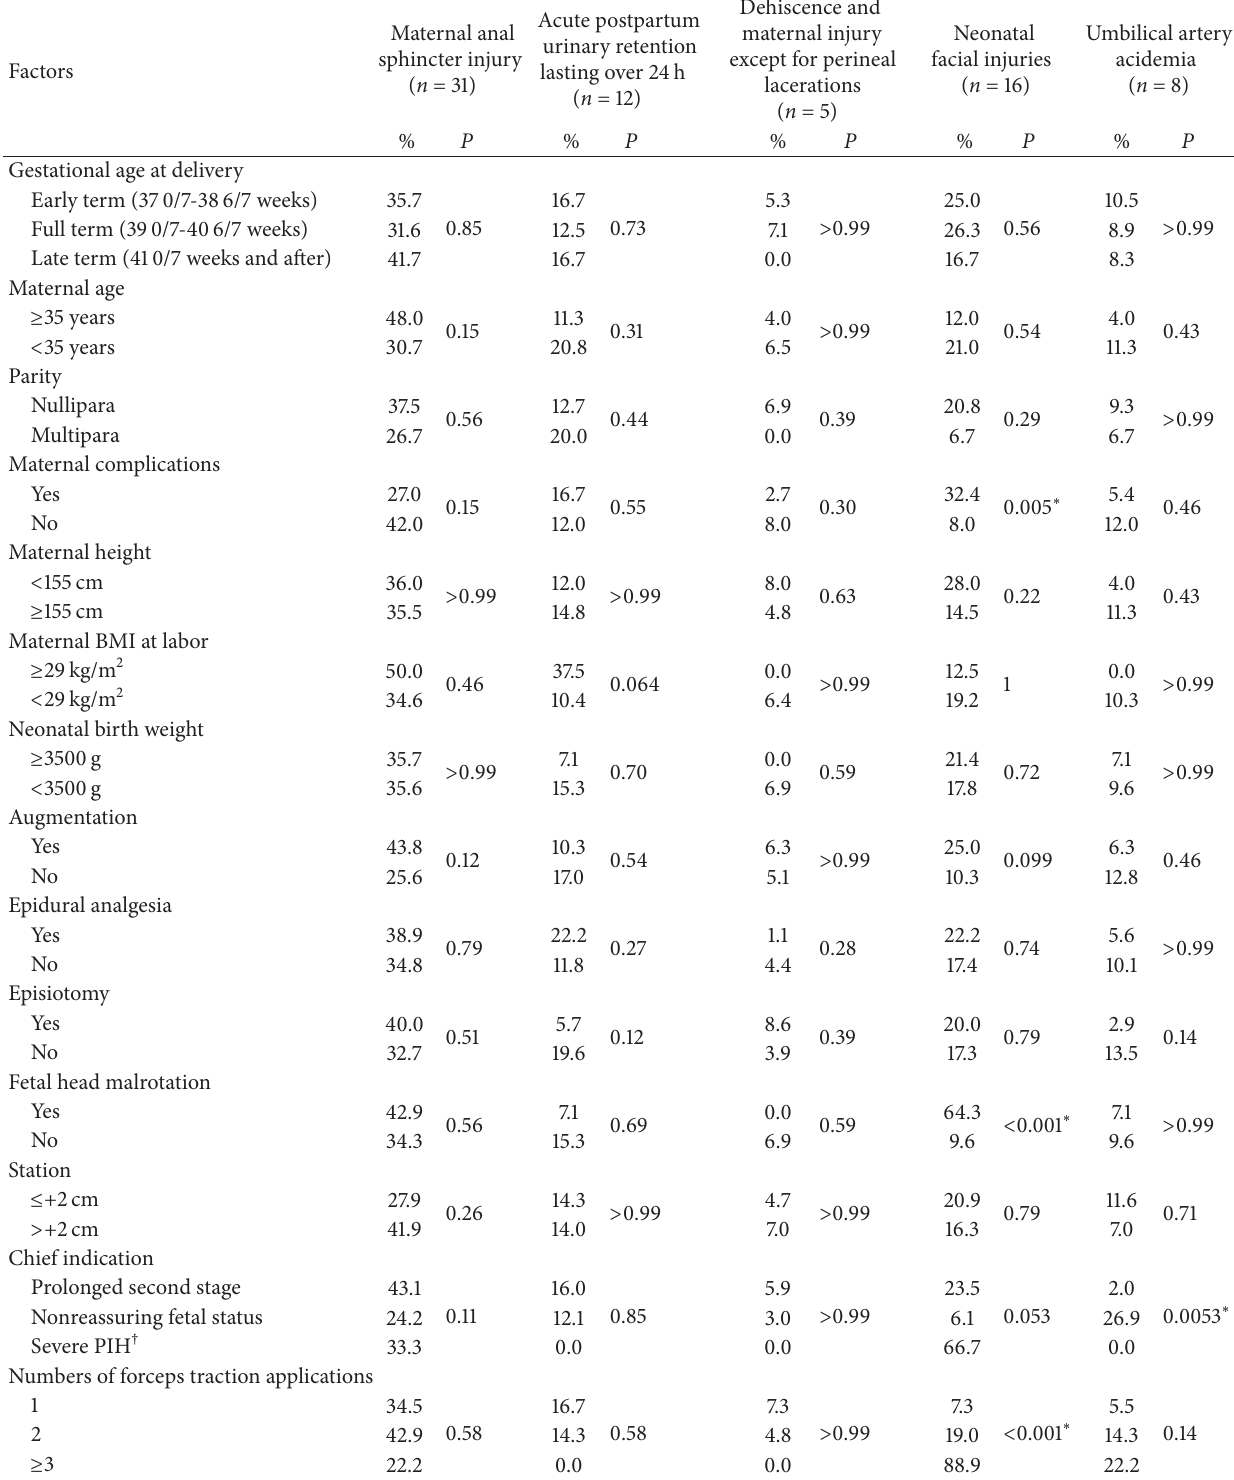
Table 3: Relationship between patient characteristics and